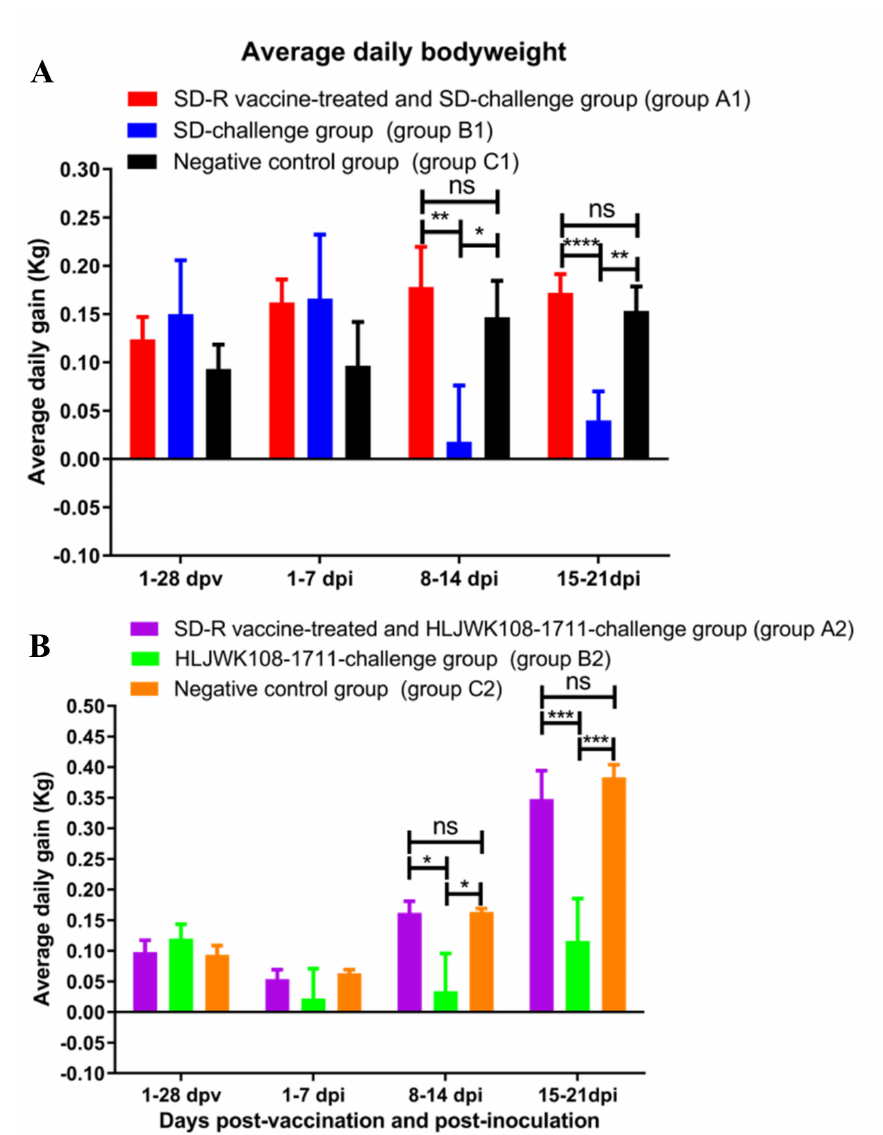
Figure 4. Effects after SD − R immunization and challenge with parental virus SD ( A ) and NADC30 − like PRRSV HLJWK108 − 1711 ( B ) on the weight of the piglets. All the experimental piglets were weighed at 0 and 28 dpv and 7, 14, and 21 dpi. The average daily gain of 5 or 3 piglets per group was calculated for days 0 to 28 dpv and 1 to 7 dpi, 8 to 14 dpi, and 15 to 21 dpi. The bars represent the average daily body weight of five or three piglets ± SD. An asterisk (*) indicates a significant difference between the group A1 and B1, B1 and C1 or the group A2 and B2, B2 and C2 (****, p < 0.0001; ***, p < 0.001; **, p < 0.01; *, p < 0.05; ns, p > 0.05). Groups A1, B1, and C1 are labelled red, blue, and black, respectively. Groups A2, B2, and C2 are labelled purple, green, and orange,